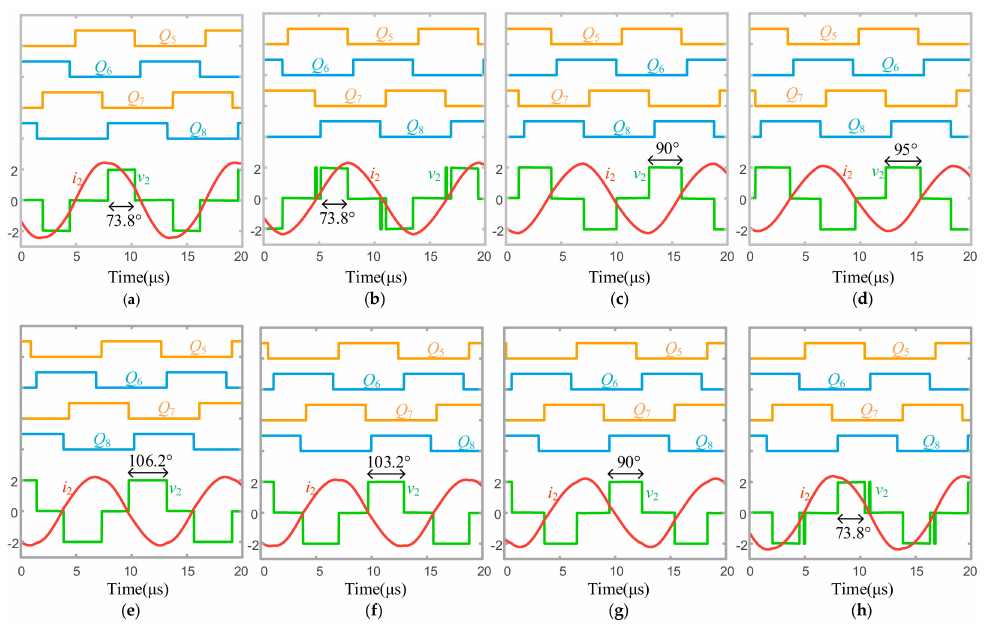
Figure 10. Simulated results of the eight kinds of dead-time effect in the DAB WPT system. ( a ) Region 1; ( b ) Region 2; ( c ) Region 3; ( d ) Region 4; ( e ) Region 5; ( f ) Region 6; ( g ) Region 7; ( h ) Region 8. i 2 : 5 A/div; v 2 : 50 V/div.